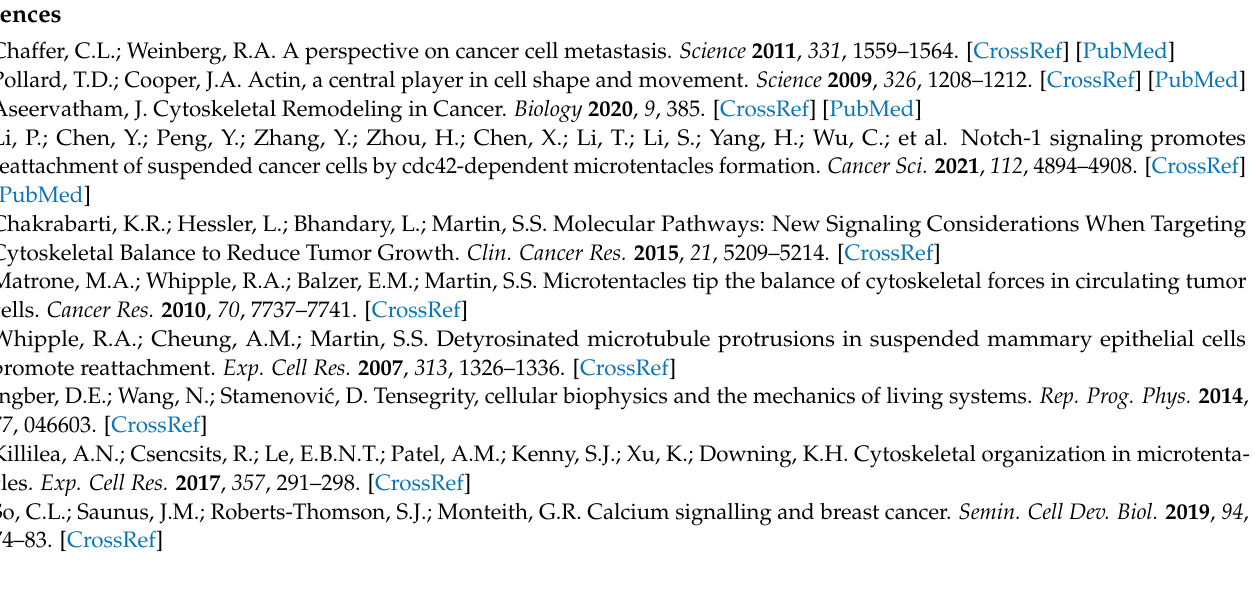
Figure S4: Densitometry results of MDA-MB-436 cells treated with the vehicle, Ionomycin, or Thapsigargin. File S1: All original immunoblot images. Method S1: Chemiluminescence and Molecular Weights: Using the iBright